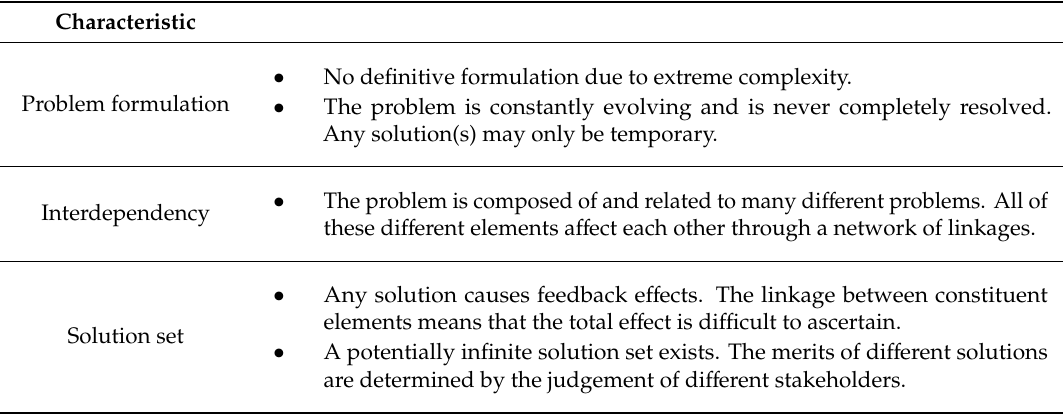
Table 1. Characteristics of wicked